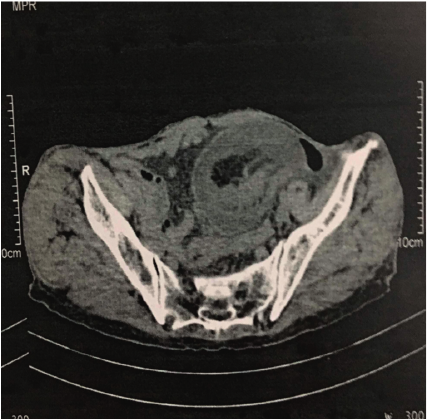
Figure 3: Abdominal CT scan showing large intestinal invagina- tion (heterogeneous digestive